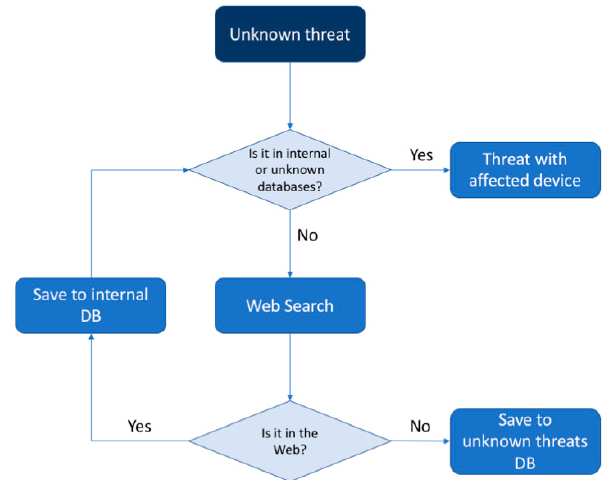
Figure 4. Graphic description of the method of enrichment of knowledge about threats followed in the development of the prototype.